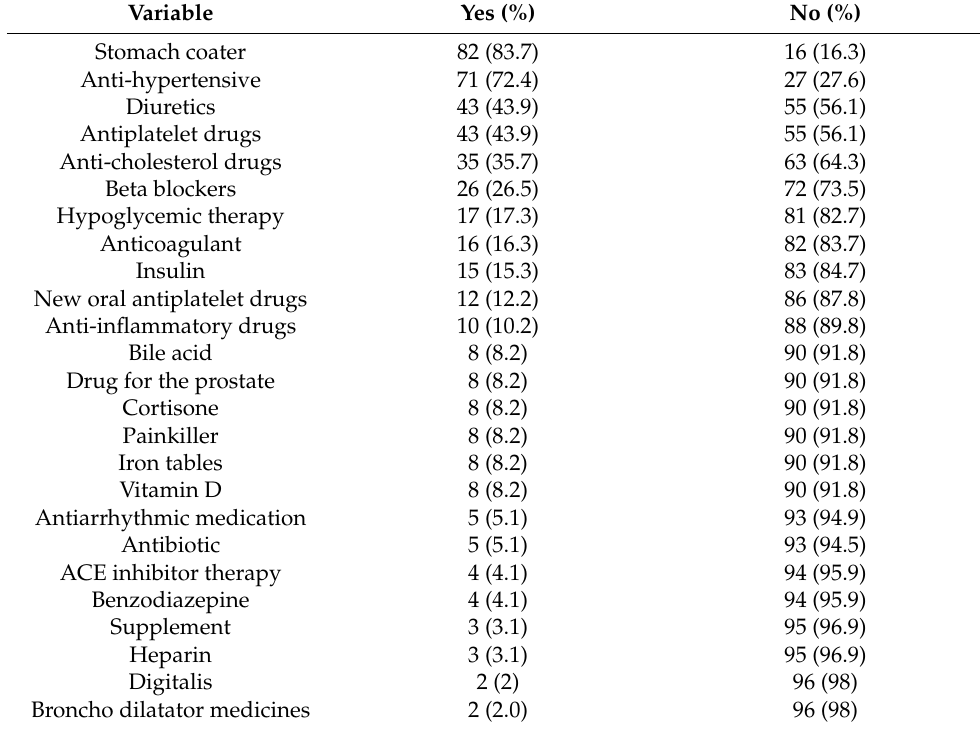
Table 2. List of drugs taken by the sample